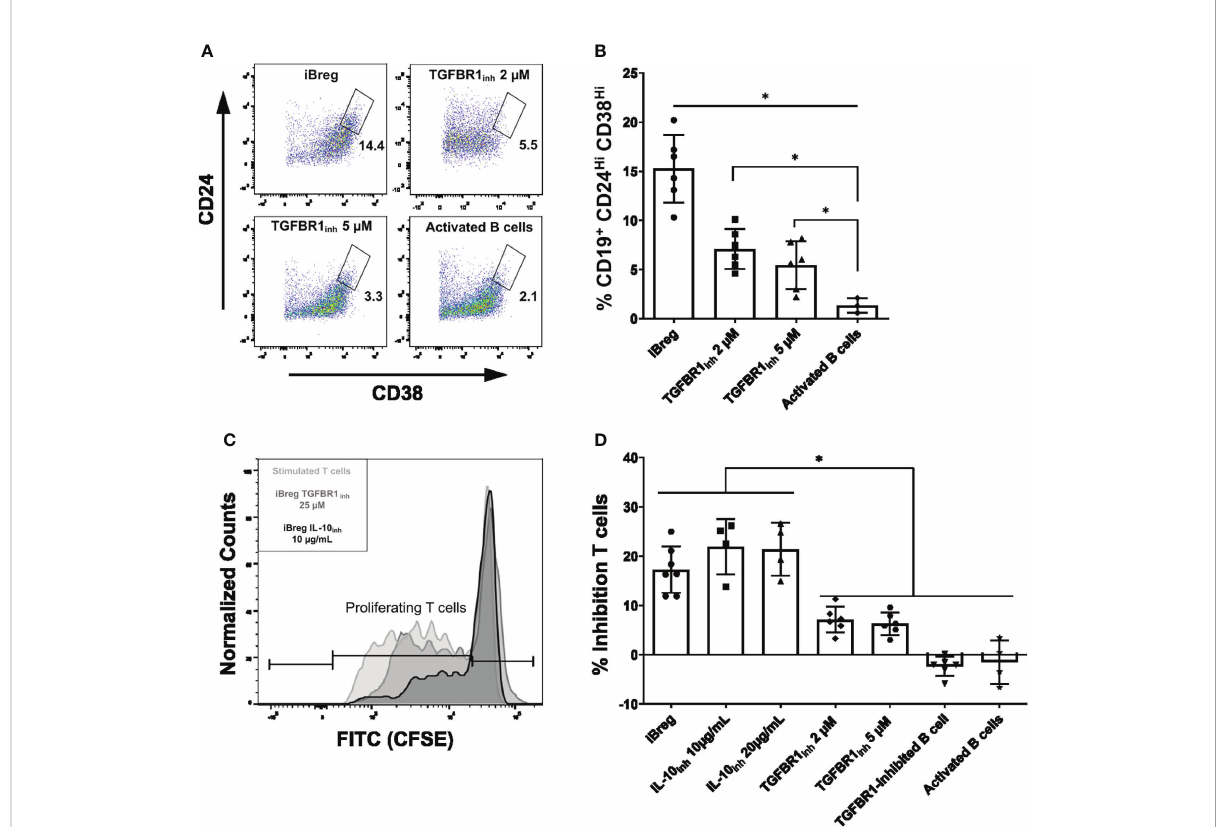
FIGURE 6 iBreg inhibition of T cell proliferation is independent of IL-10 effect on T cells. (A) Representative FACS plots showing the percentage of Transitional B (CD19 + CD24 Hi CD38 Hi ) cells from alive B cells (CD19 + 7AAD - ). (B) Summarized data for the frequency of Transitional B cells in iBreg. TGFBR1 inhibitors signi fi cantly reduce transitional B cells induction by MSC, but are not comparable to activated B cells levels, highlighting a partial inhibition of MSC effect. (C) Histogram representing CFSE expression on T cells. Lighter grey represents stimulated T cell. Light grey and dark grey represent, stimulated T cells coculture with iBreg at 1:2 T to B cell ratios in the presence of an IL-10 neutralizing antibody or a TGFBR1 inhibitor, respectively. (D) Bar graph representing reduction of proliferating T cells for each condition compared to stimulated T cells controls. iBreg and iBreg samples with IL-10 neutralizing antibodies (IL-10 inh 10 and 20 µg/mL) show equal inhibition of T cell proliferation, which is signi fi cantly increased when compared to activated B cells. iBreg samples with TGFBR1 inhibitor (TGFBR1 inh 2 and 5 µM) show reduced suppression capabilities, while not being signi fi cantly different from activated B cells and B cells from MSC cocultures that were cocultured in the presence of inhibitor from day 0 (TGFBR1-inhibited B cells). Data shows at least three independent experiments in each group. Cells from 2 MSC donors and 3 Tonsil donors were used. Error bars represent SD. One-way ANOVA was performed to determine statistical signi fi cance. *p <